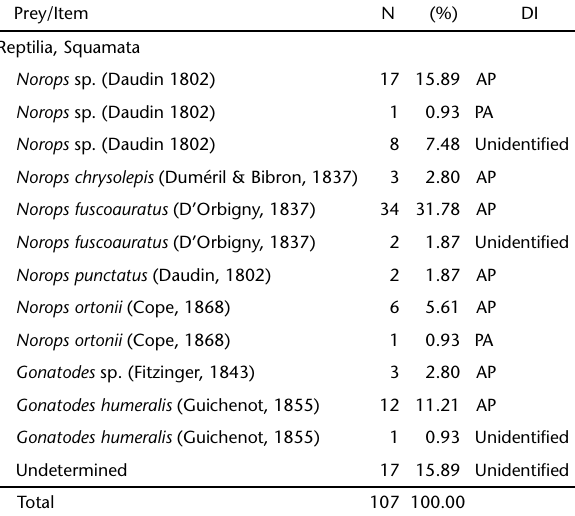
Table II. Contents of the digestive tract of Imantodes cenchoa from the Brazilian Amazon. (N) Number of prey; Undetermined = food content in an advanced state of digestion; (Di) Direction of ingestion, (AP) antero-posterior, (PA) postero-anterior; Unidentified = food content for which the direction of ingestion was not verified due to its advanced state of digestion. Prey/Item N